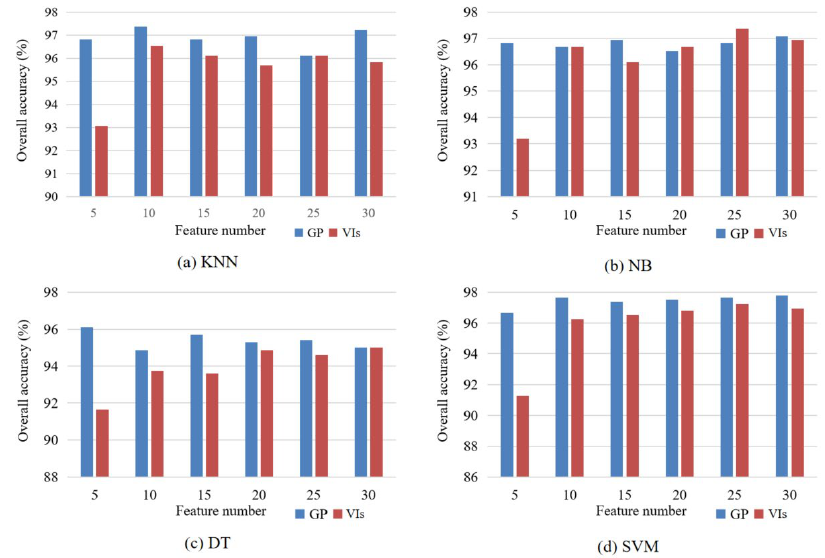
Figure 12. Comparisons of classification accuracies of ( a ) KNN, ( b ) NB, ( c ) DT, and ( d ) SVM using features learned by GP and selected from VIs.